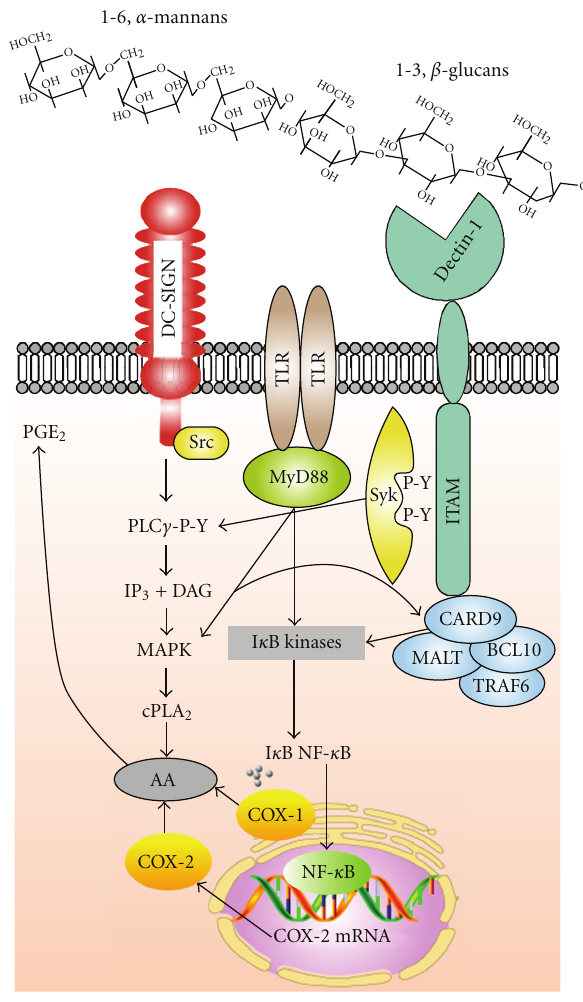
Figure 6: Diagram of AA metabolism in DC stimulated with zymosan particles. The mannan and β -glucan components of zymosan are recognized by at least DC-SIGN, TLR2, and dectin-1. This gives rise to a series of signaling events implicating activation of Syk and Src families of tyrosine kinases. Both routes converge to activate phospholipase C γ and through the generation of diacylglyc- erol activate protein kinase C and mitogen-activated protein kinase (MAPK) cascades. Phosphorylation by MAPK and Ca 2+ -driven translocation of cPLA 2 explain AA release from cell phospholipids. Activation of I κ B kinases via MyD88 is a major factor explaining COX-2 induction. The CARD9/MALT1/BCL10/TRAF6 complex is involved in the activation of I κ B kinases. DAG, diacylglycerol; IP3, inositol 1,4,5-trisphosphate; PLC γ , phospholipase C γ ; P-Y, phosphotyrosine.